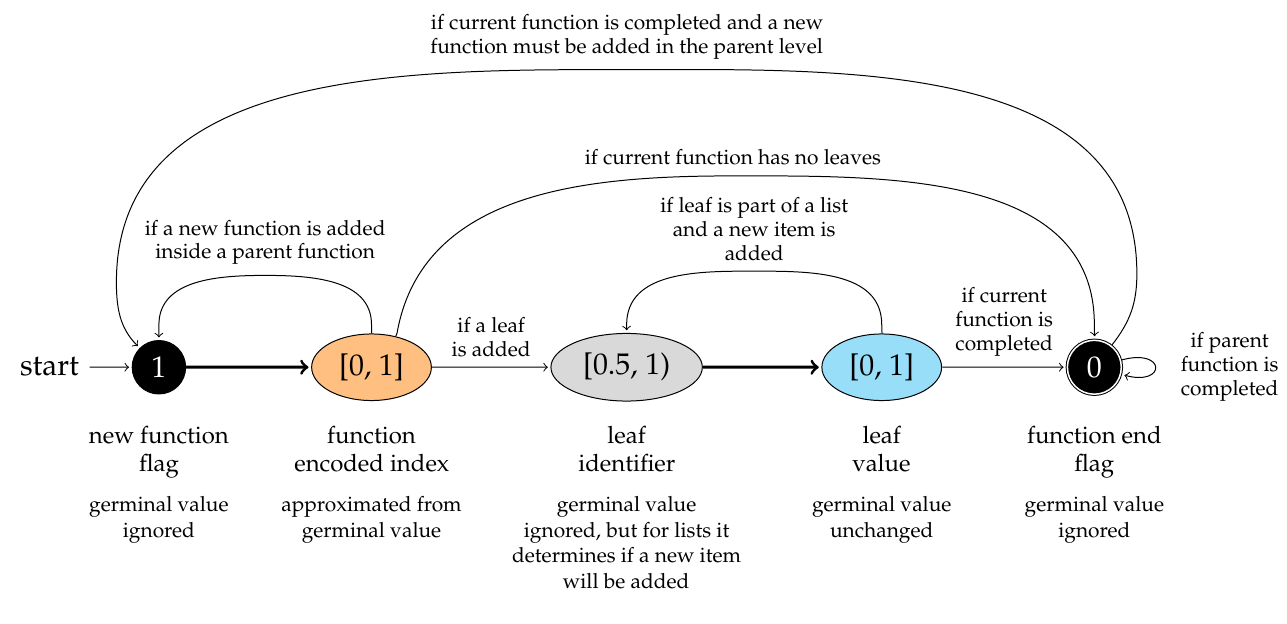
Figure 6. Numerical transformations applied by the map trans to create encoded genotypes from germinal vectors. Black and gray values work as flags and identifiers that replace the original numbers of a germinal vector. Orange indicates that a golden value conversion is needed to create an exact reference to a genotype function. Values in cyan nodes are not changed, since they correspond to leaf parameters fed as numeric arguments to terminal functions.